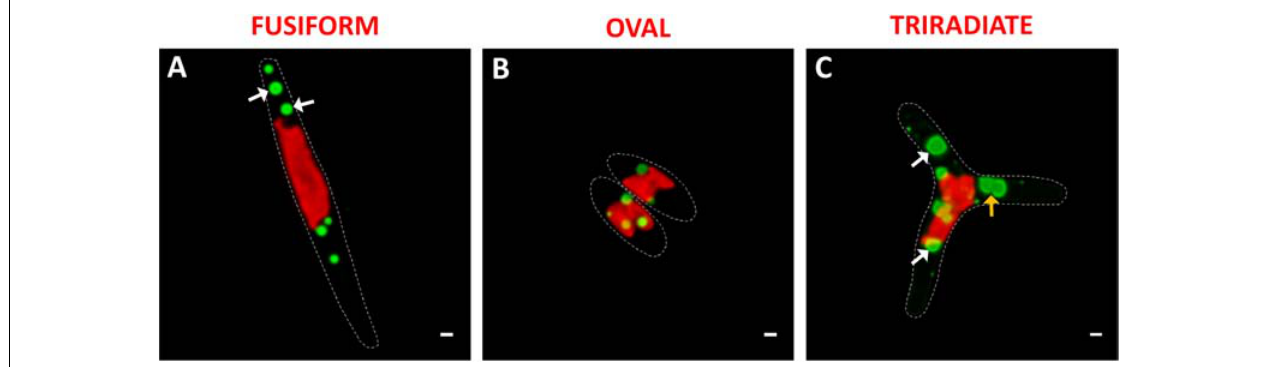
FIGURE 5 | Localization of lipid droplets in living P. tricornutum Pt3 morphotypes. (A–C) Localization of lipid bodies in Pt3 morphotypes after staining with Bodipy 505/515. Combination of Bodipy 505/515 images with plastid autofluorescence. White arrows indicate lipid bodies with very clear outer ring. Orange arrow illustrate fusion between two lipid bodies. Bars, 1 µ